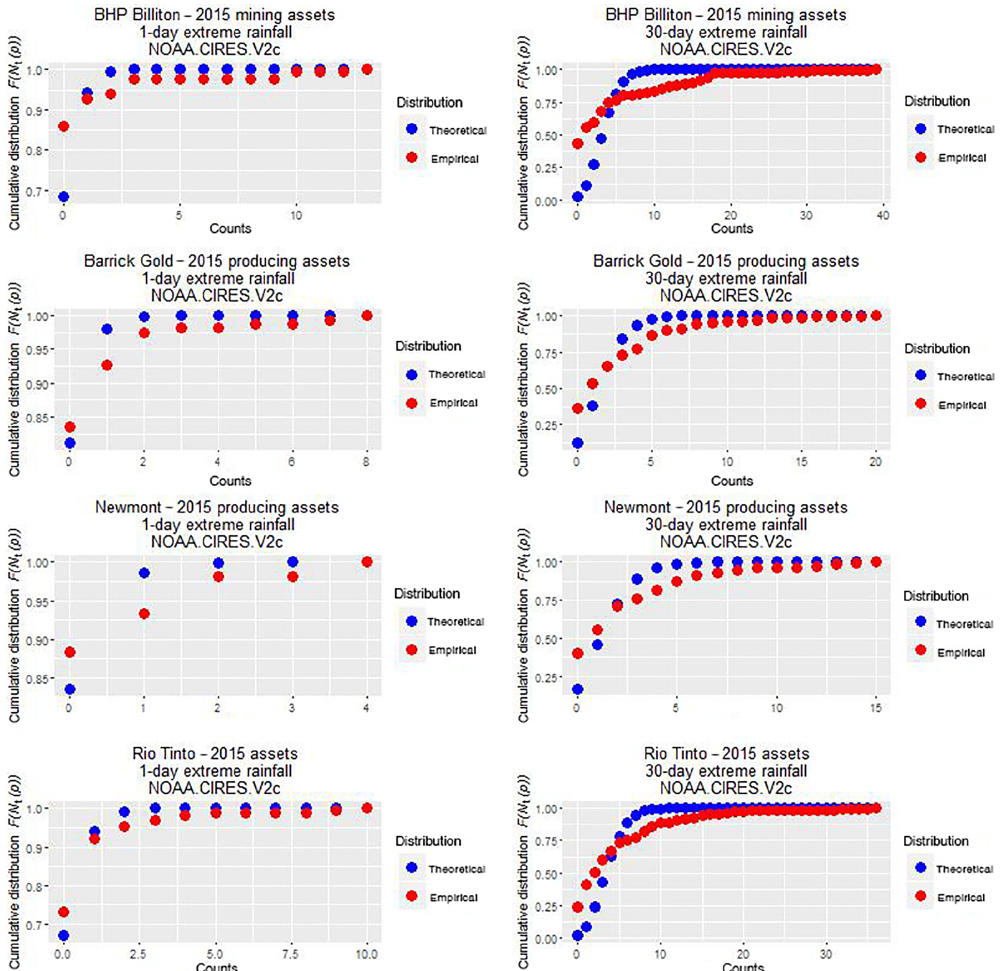
Figure C1. Comparison of the cdf’s of the yearly number of 1-day (left panels) and 30-day (right panels) extreme rainfall events hitting the BHP, Barrick Gold, Newmont and Rio Tinto mine portfolios with the corresponding theoretical cdf’s assuming independence of events in space and time (Poisson processes). Empirical distributions were derived from the N t (p) time series using the ecdf R function, which computes an empirical cumulative distribution function. The 20CR dataset was